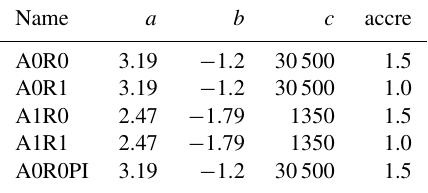
Table 2. Names of each E3SM simulation experiment based on dif- ferent parameterizations of the KK2000 autoconversion and accre- tion enhancement factor schemes. The final experiment represents pre-industrial (PI) aerosol emissions using the A0R0